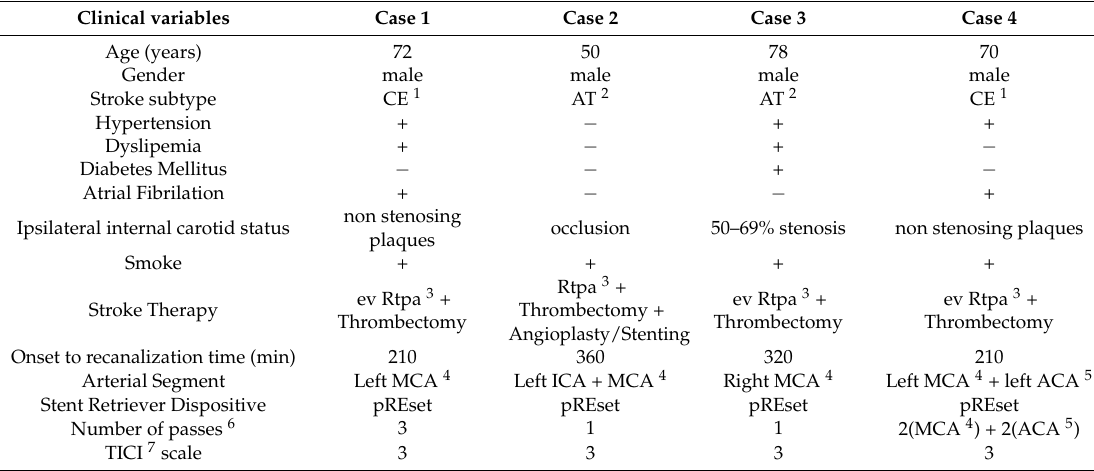
Table 1. Neuroimaging and clinical characteristics.